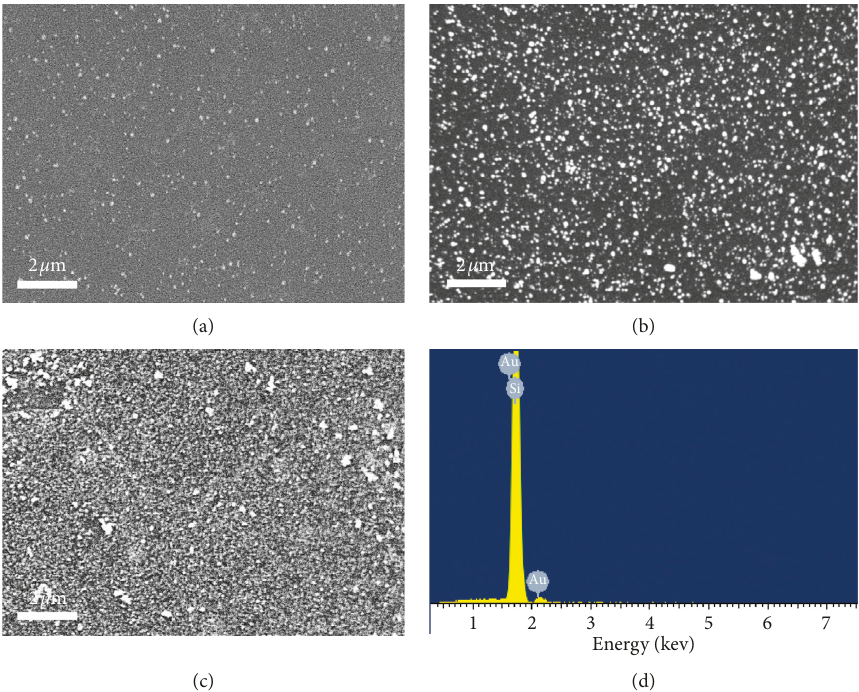
Figure 1: SEM image of the Si surface covered with gold deposited from a solution containing 2 mM (a), 4mM (b), and 8mM (c) H[AuCl by the GR method in the DMSO solvent for 1min at 50 ° C and EDX spectrum